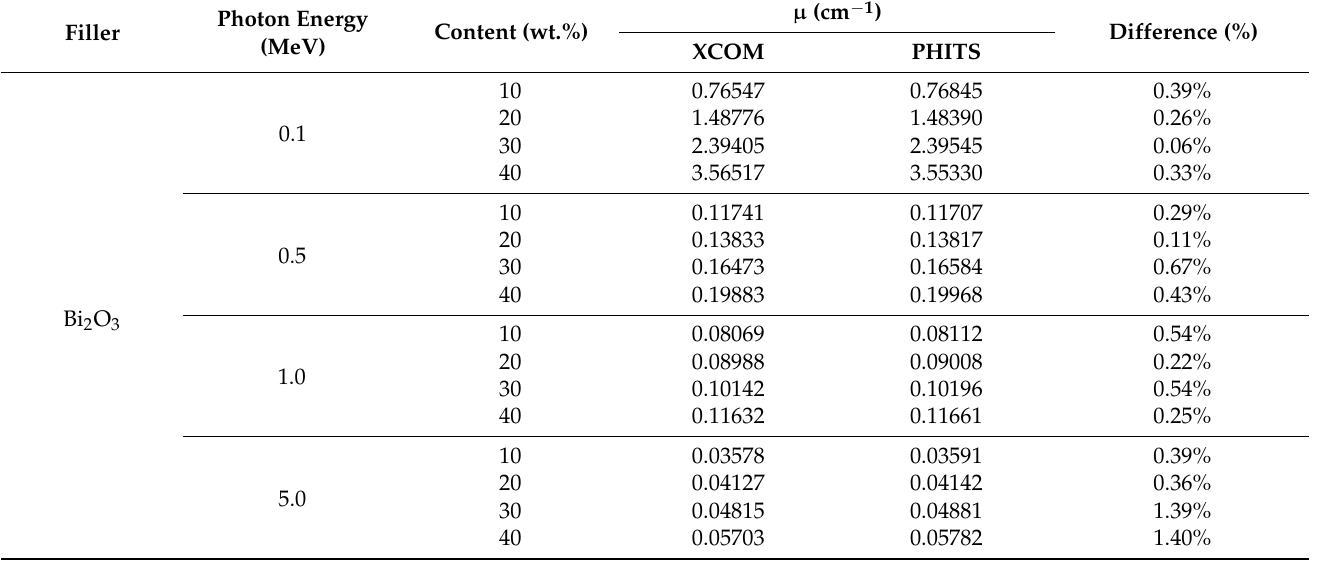
Table 3. Comparative µ m values obtained from XCOM and PHITS for PVA hydrogels containing Bi 2 O 3 , WO 3 , and BaSO 4 at varying photon energies of 0.1, 0.5, 1, and 5